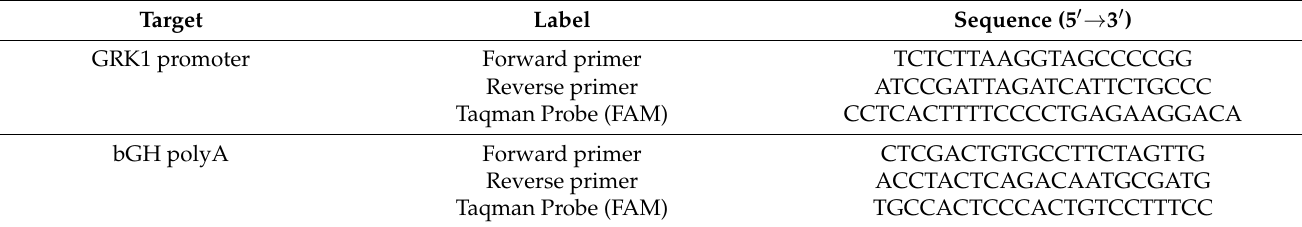
Table 1. Primers and probes designed to quantify AAV.RPGR titre.